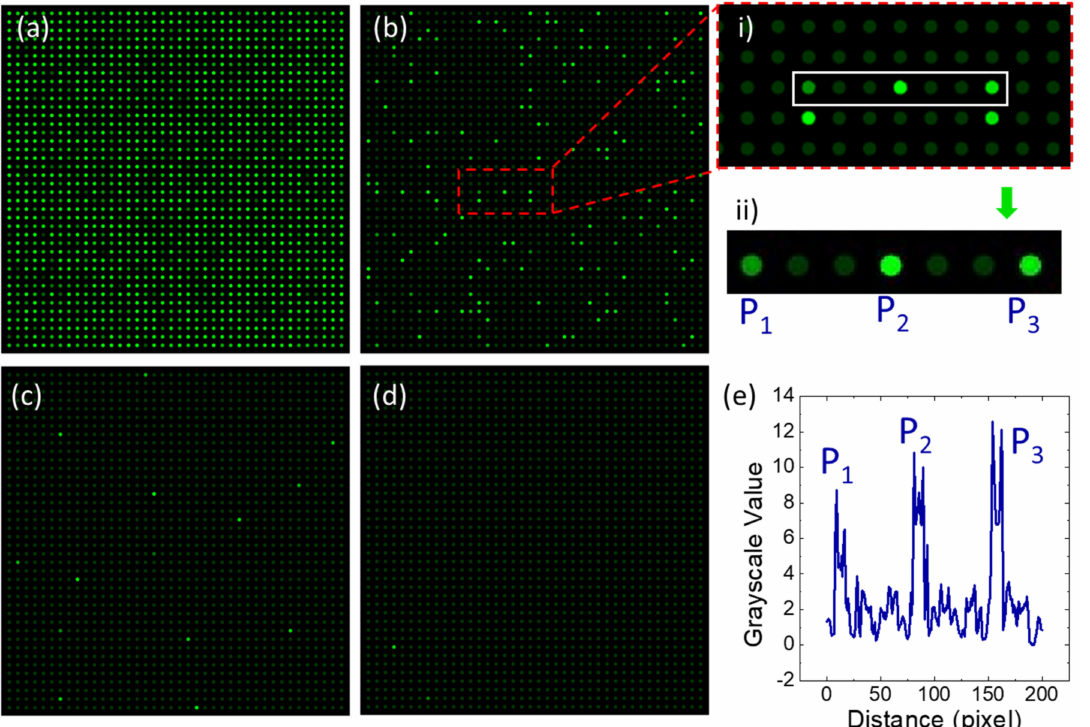
Figure 4. Applications in meat authentication for mixtures of mutton and chicken samples. ( a – d ) are fluorescence images read by the CCD camera, for experimental samples 1–4 listed in Table 1, with chicken/mutton mass ratio of 1:1, 1:10, 1:100, and 1:1000, respectively. ( e ) is the plot of gray scale as a function of distance for the part of images shown in subfigure ( b